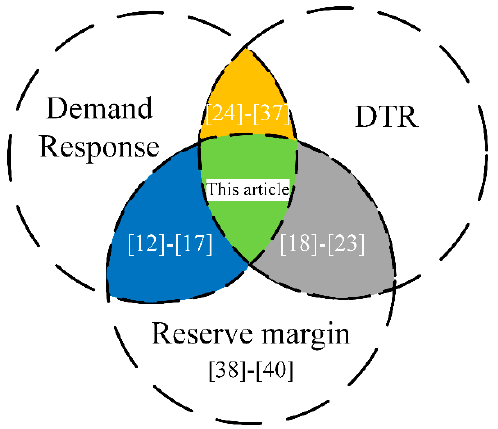
Figure 1. Scope of the paper with regard to the literature survey.